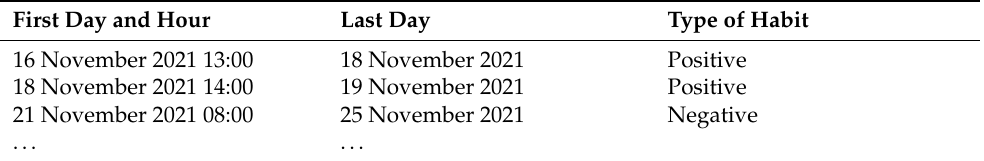
Table 3. Example of data frame with detected sustained behaviour